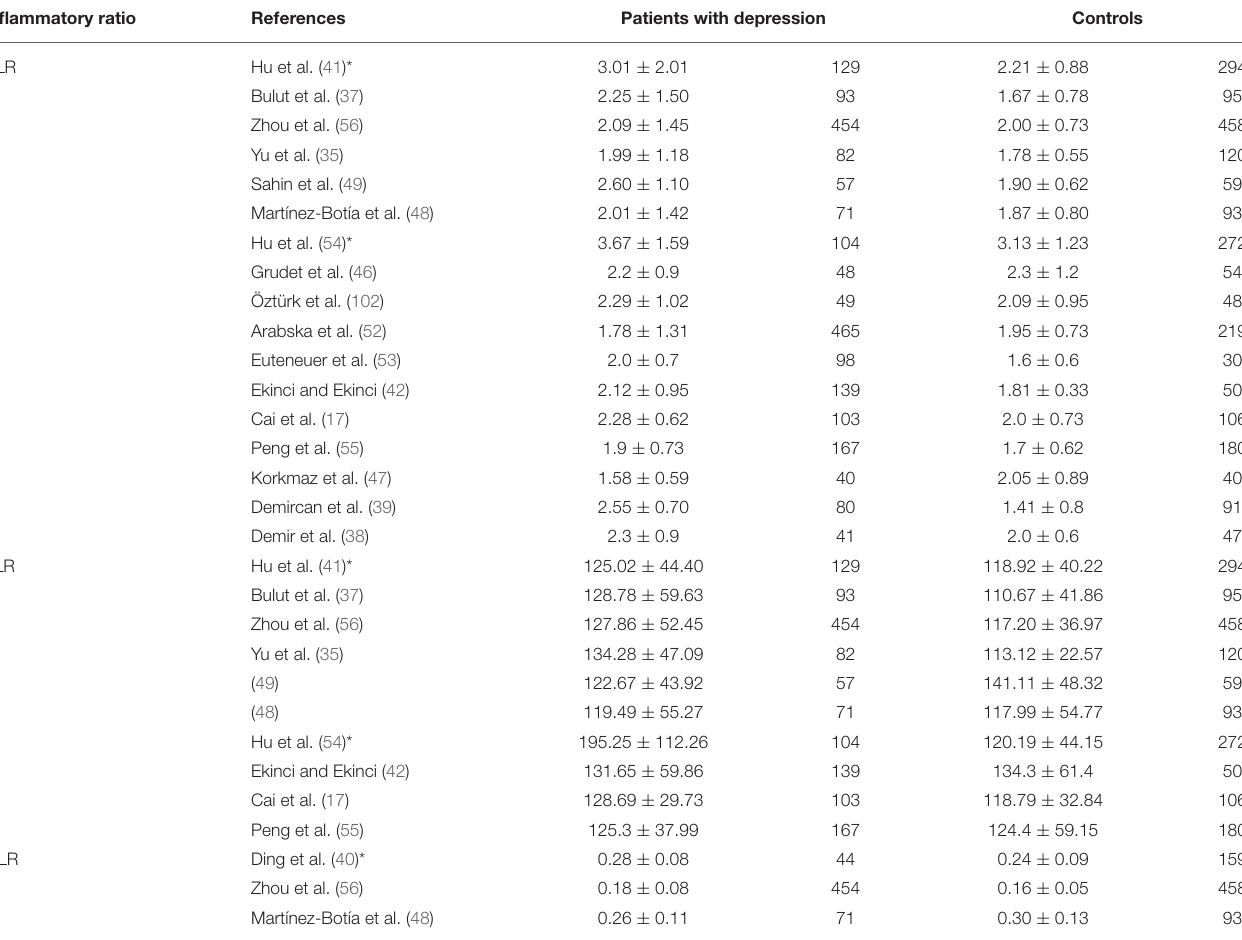
TABLE 2 | Comparison of NLR, PLR, MLR between patients with depression and controls. Inflammatory ratio